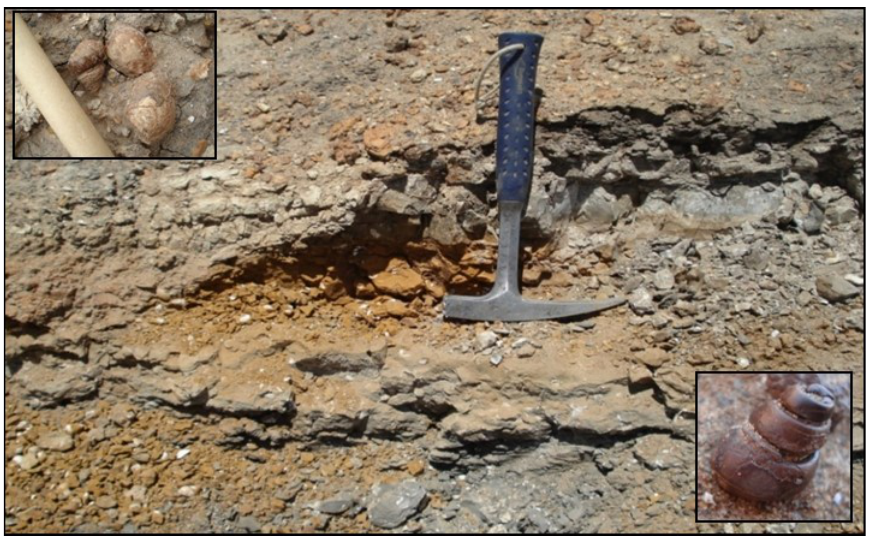
Fig. 9. View of mollusca-bearing siltstone and mudstone beds (hammer for scale) outcrops located in the upper part of coal-bearing sediment package (scale for molluscs 1:2)